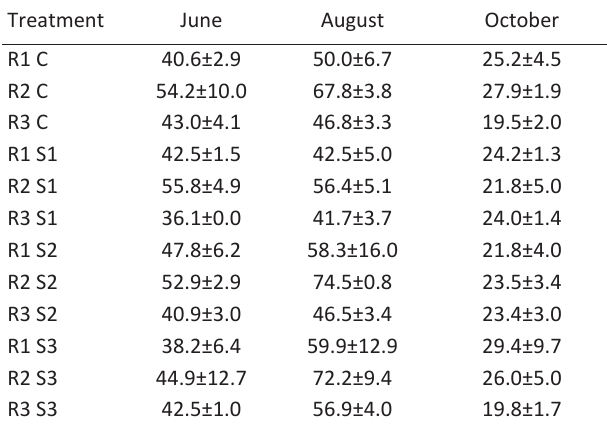
4 - The effect of brackish water treatments on the aver- age ‘Superior Seedless’ Ca leaf content (mg g -1 dry weight) grafted on the three rootstocks measured in April, June and november Treatment